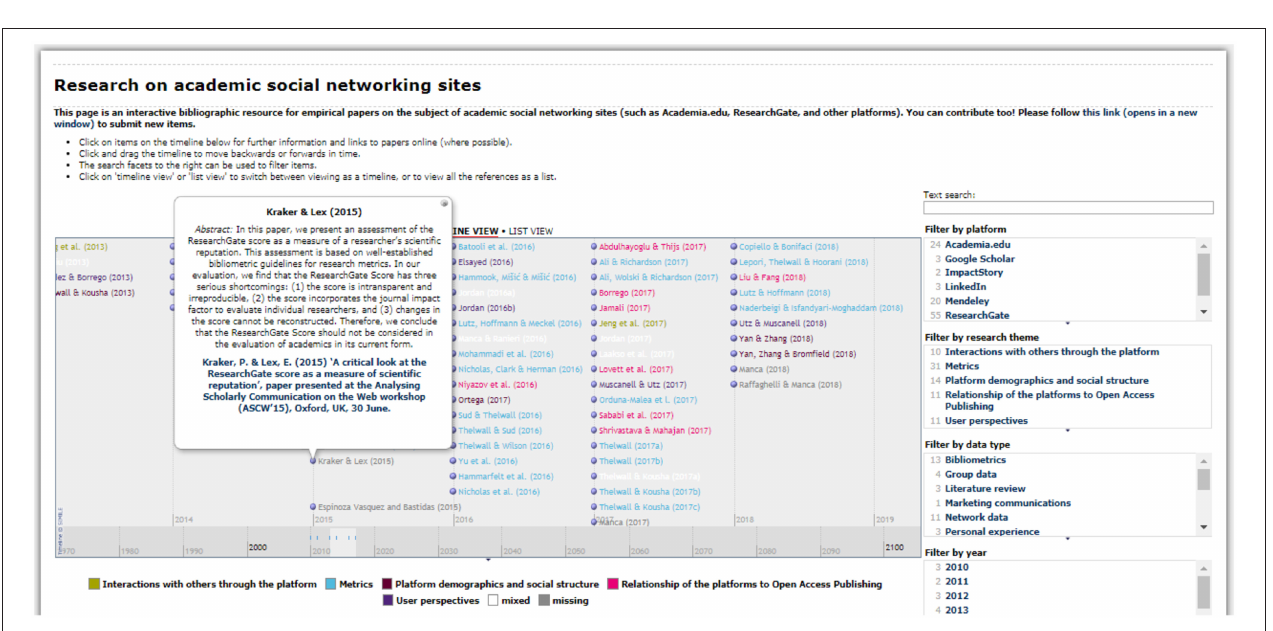
FIGURE 2 | Screen capture of the online bibliography, displaying items on a timeline color-coded according to themes. Clicking on an item on the timeline displays citation information, and an outward link to the publications’ location online. The panel to the right comprises faceted browsing to filter the records on display, and text